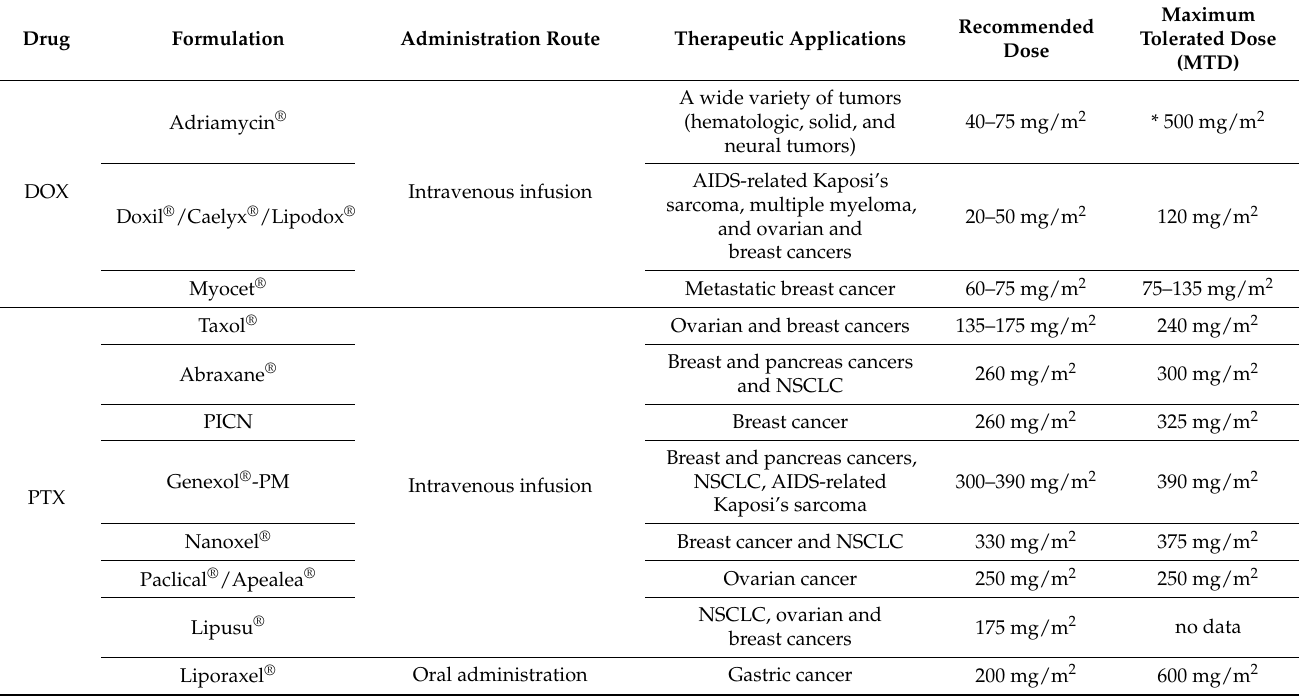
Table 1. Main characteristics of doxorubicin (DOX) and paclitaxel (PTX) formulations, such as their administration route, therapeutic applications, recommended dose, and maximum tolerated